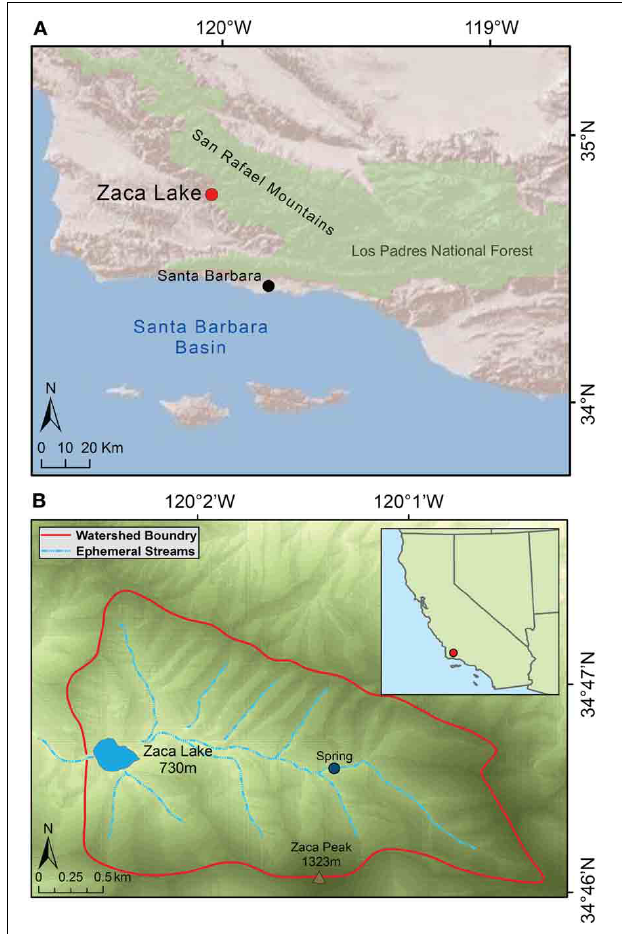
FIGURE 2 | Map of Zaca Lake location. (A) Santa Barbara Region ( B) Zaca Lake watershed.